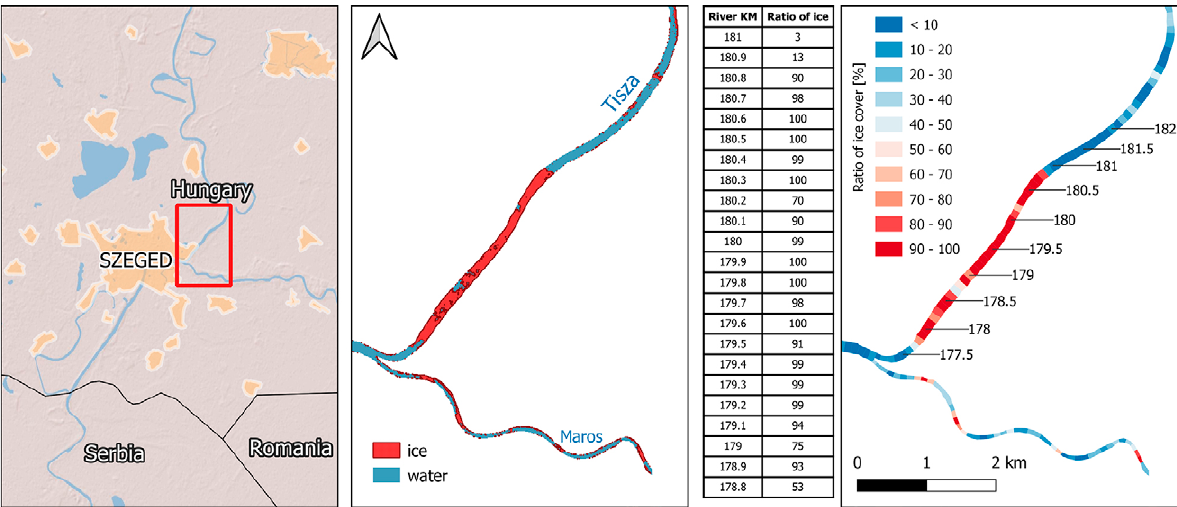
Figure 6. Results of the radar based ice coverage calculation of January 27, 2022 for a Tisza subsection near Szeged in Hungary (left), the 10 x 10 metre resolution ice coverage (middle) and the polygon map showing the ratio of the river covered with ice per 100 metre section (right)